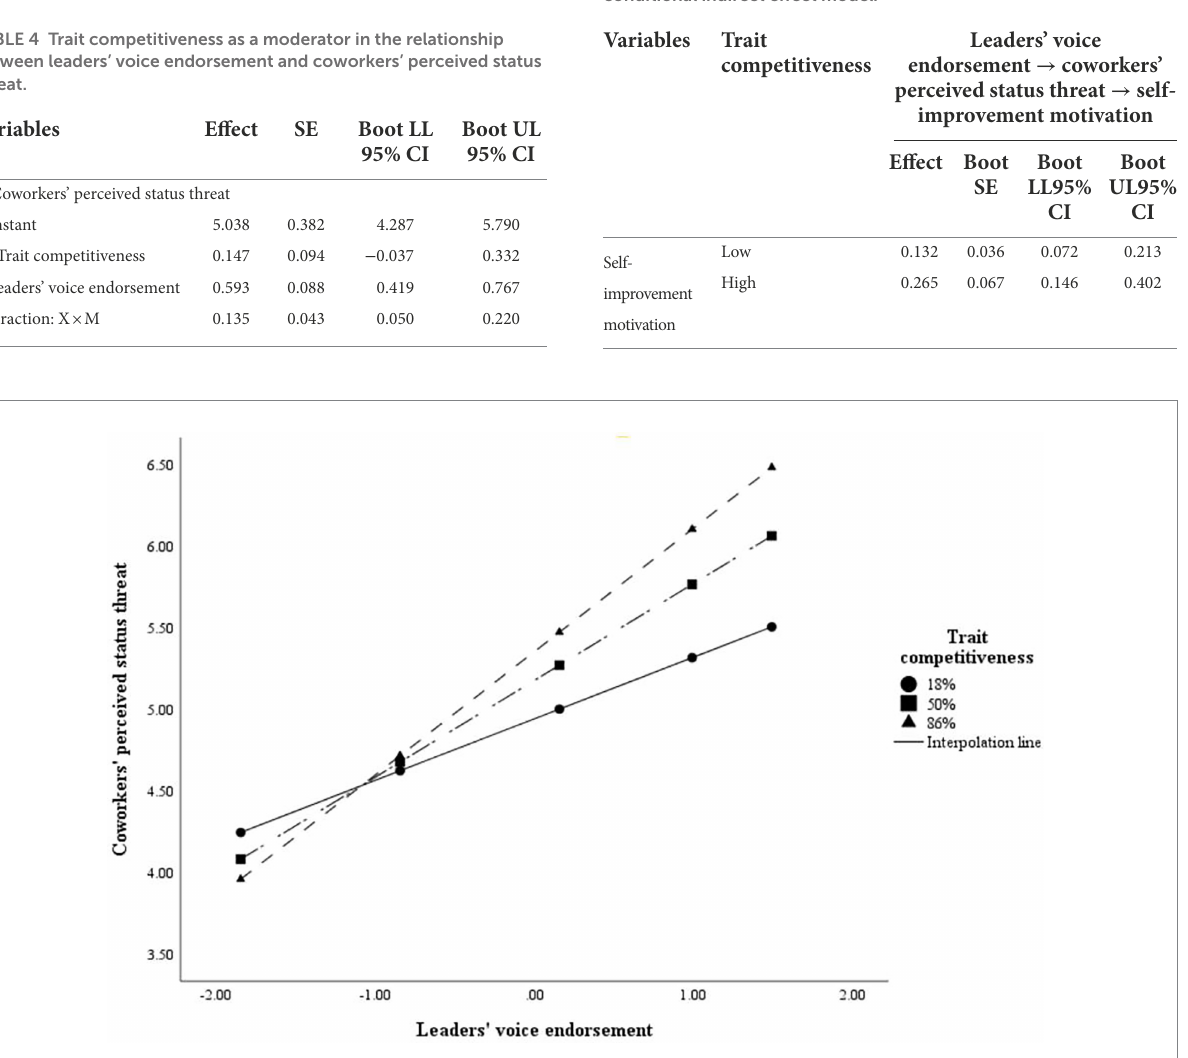
TABLE 5 Coworkers’ trait competitiveness as the moderator in conditional indirect effect